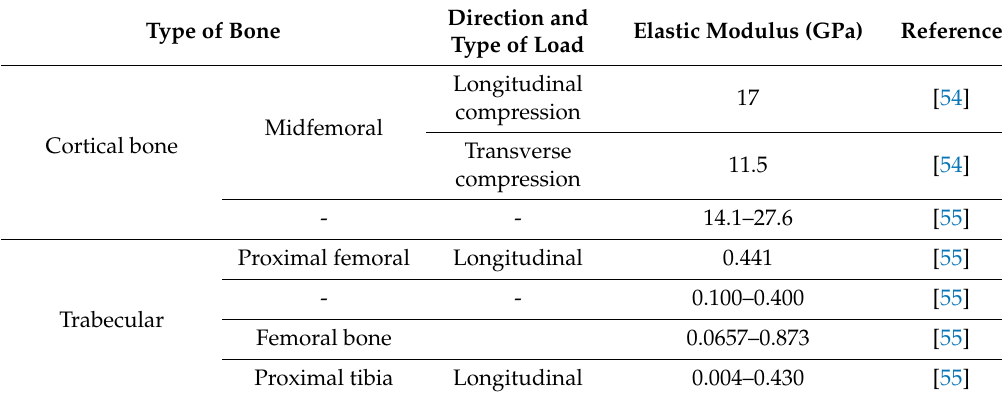
Table 3. Elastic modulus of human cortical and trabecular